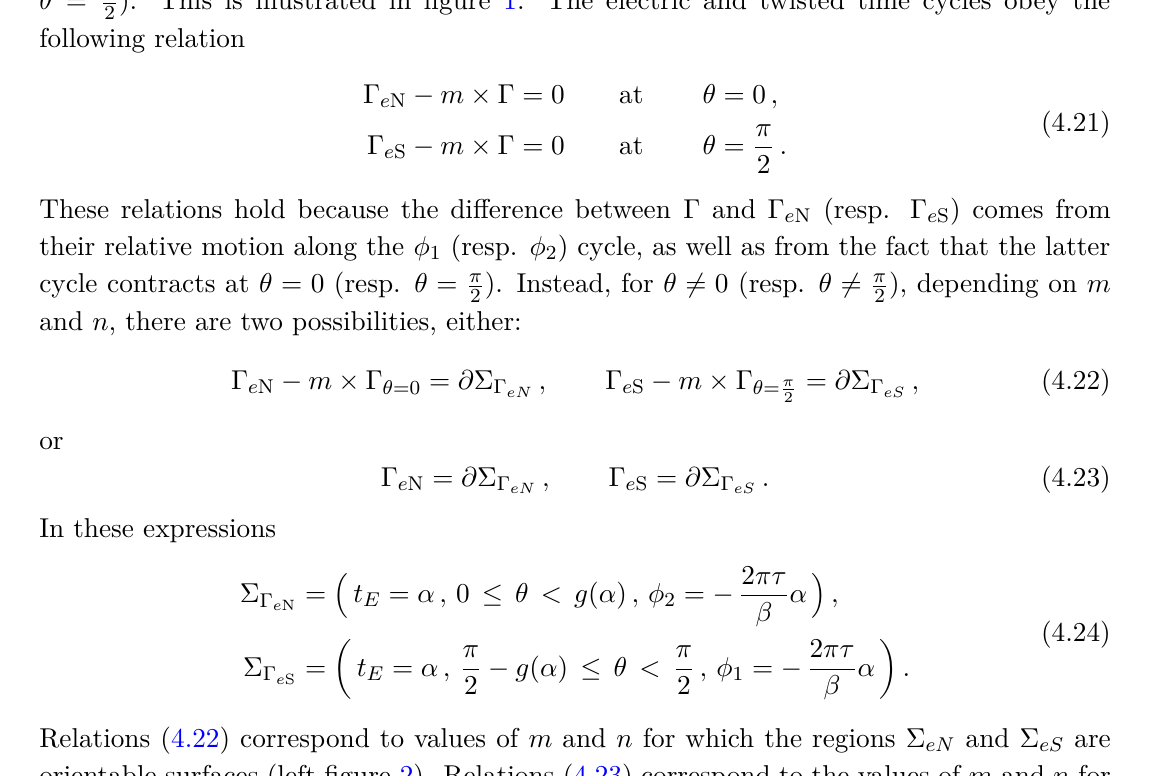
Figure 1 . Schematic representation of the twisted time (grey), electric north (blue) and magnetic north (red) cycles in the singular coordinates where the fibration looks trivial. This representation is obtained after implementing the singular change of coordinates φ frame ). The loops in the hemisphere represent two-tori. One of the cycles of the tori contracts at the north pole; the other one remains finite size. The magnetic and electric cycles move along the former and are static on the latter. The twisted time cycle does not move along the S frame. The figure does not represent the electric cycle’s non-trivial winding numbers, which are m around the base S 1 and n around the north locus represented with the letter N in the figure. When located at the north (resp. south) locus N (resp. S ) the electric north (resp. south) cycle is identical to m copies of the twisted time